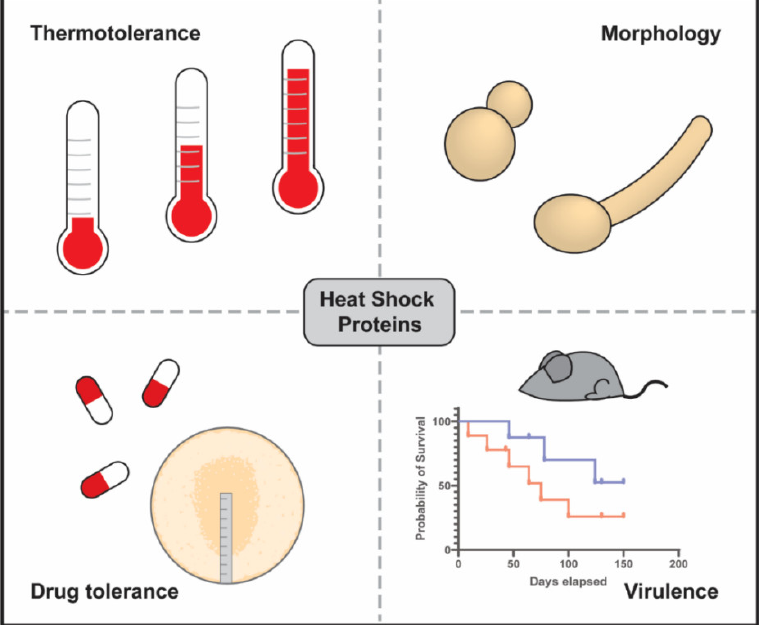
Figure 1. The major roles of heat shock proteins (HSPs) in fungal pathogens. The HSPs facilitate the acquisition of thermotolerance and allow human fungal pathogens to grow at human body temperature as well as to survive after heat shock at elevated temperatures. Several of these chaperones are required for morphological changes including the yeast to hyphal transition and conidiation. The HSPs, and in particular the Hsp90s, also facilitate antifungal drug tolerance in the major fungal pathogens suggesting that inhibitors would potentiate the activities of existing antifungals. Finally, in mammalian and insect models of infection when HSPs were pharmacologically inhibited or upon inoculation with deletion mutants lacking a gene for an HSP, they were often attenuated for virulence (indicated by the blue line in the hypothetical survival curve) compared to wild type or untreated strains (red